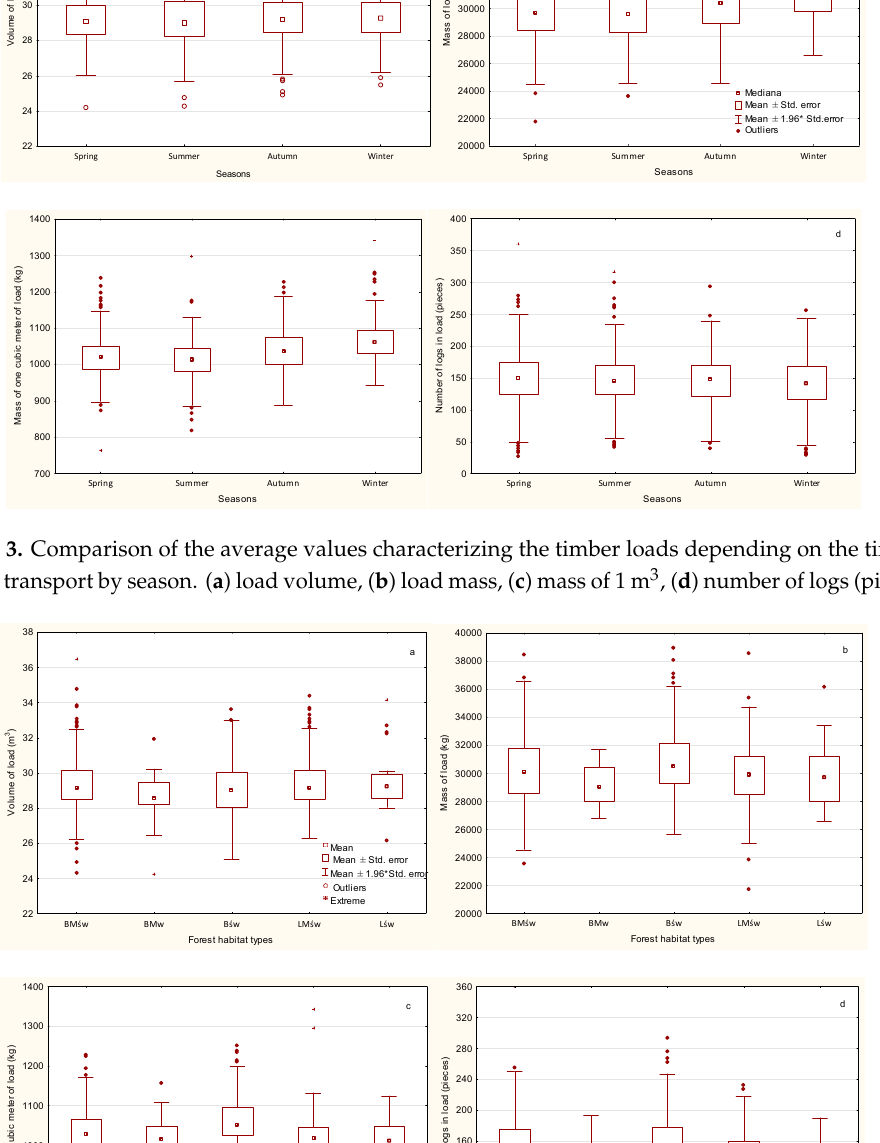
BMw) and BM ś w (different from BMw and LM ś w) (Figure 4d).